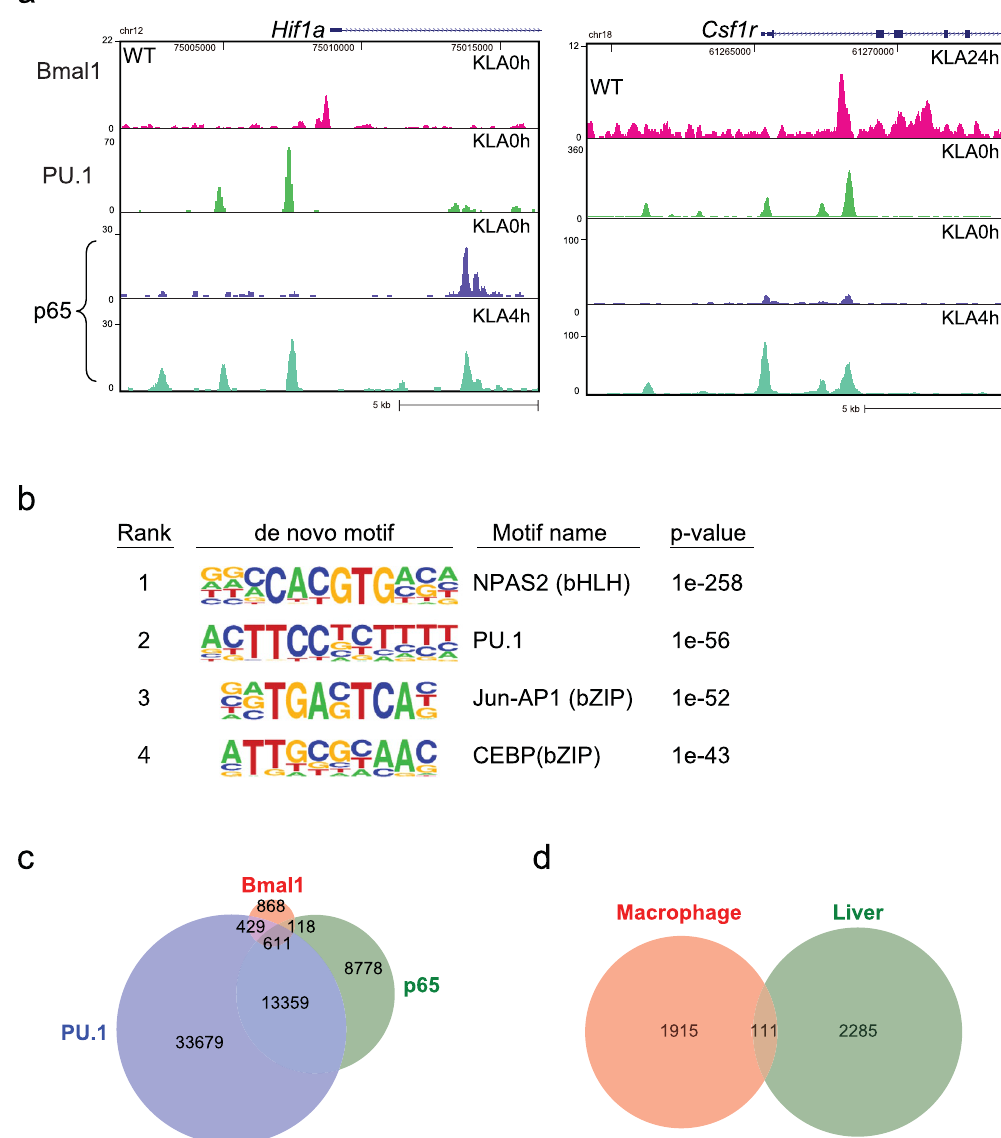
comparable between the two genotypes 4 h after KLA, the elevation in H3K27ac persisted beyond 4 h in Arntl − / − cells. These altered H3K27ac states are exemplified by the Irf1 locus (Fig. 6b). Moreover, the persistent activation